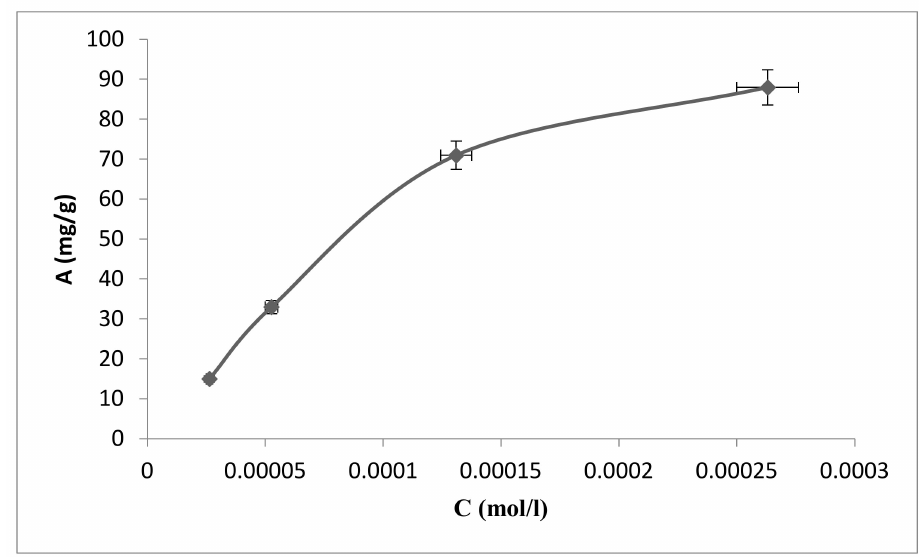
Figure 2. Dependence of the adsorption capacity on the fluoride ions solution concentration (ratio of adsorbate–adsorbent solution 1000:1